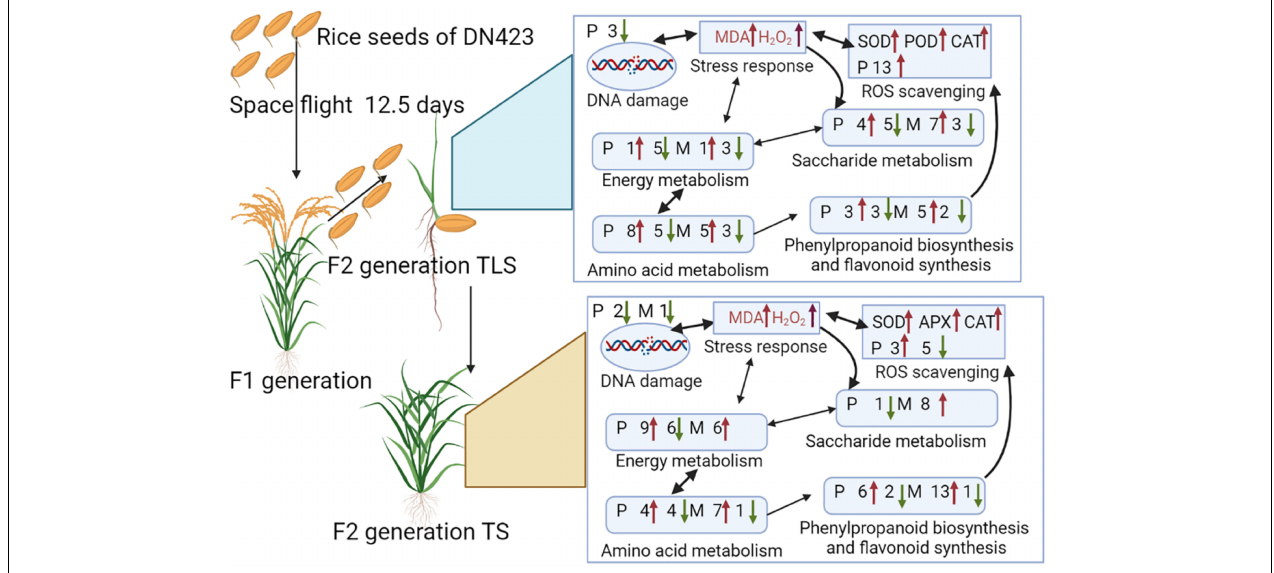
FIGURE 11 | Mechanisms of memory in response to space flight stress in F2 generation rice. P represent proteins; M represent metabolites; numbers indicate the amount of proteins and metabolites; red and green arrows represent increase and decrease, respectively.